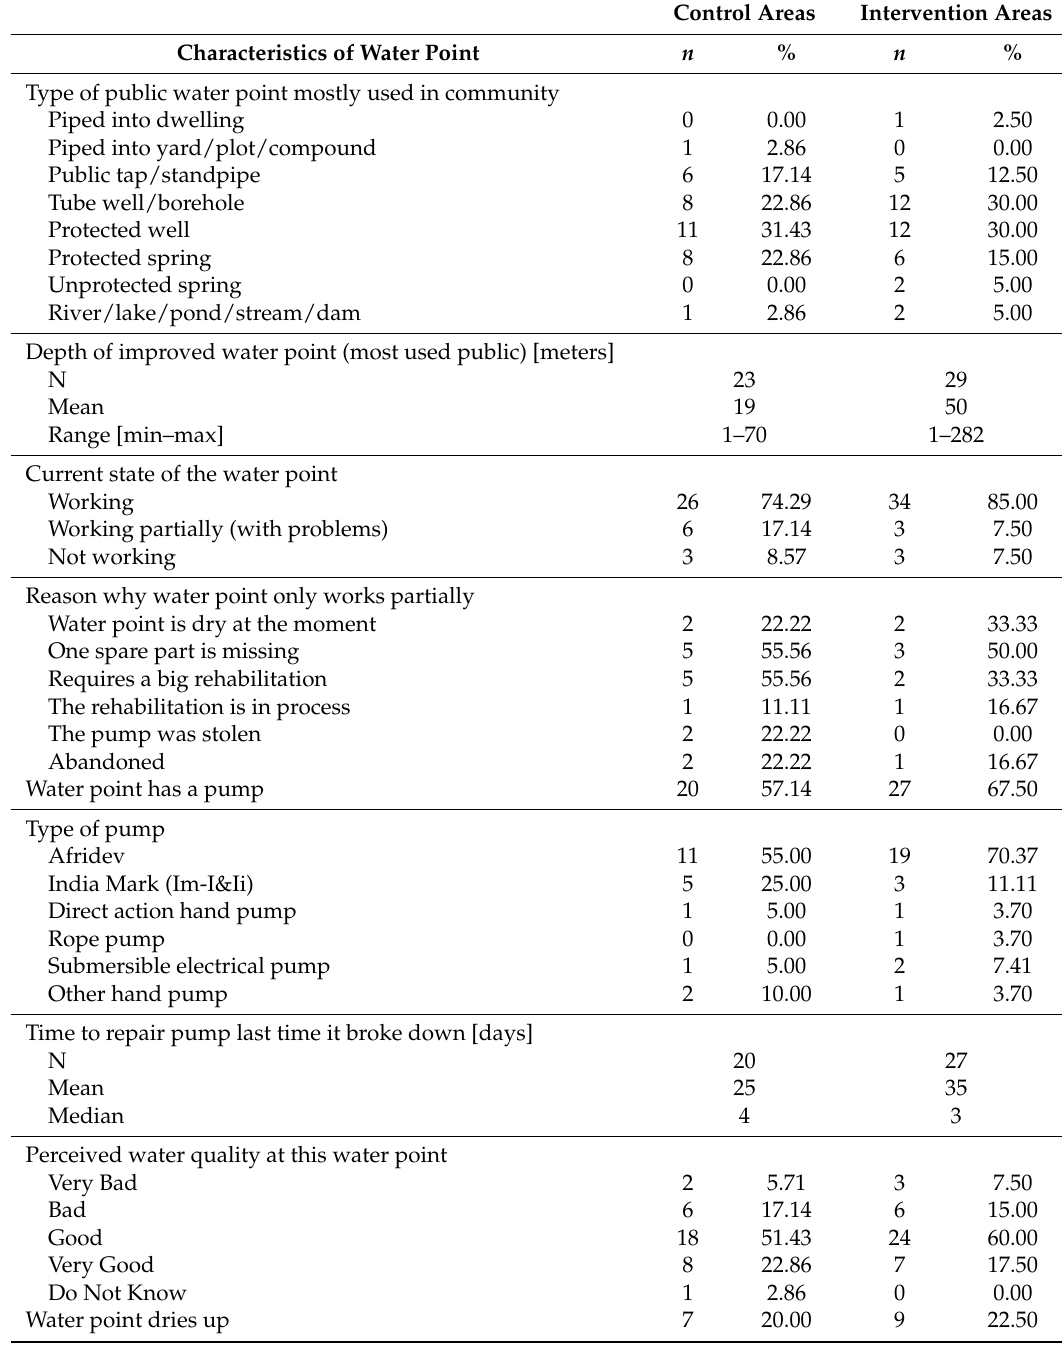
Table 5. Characterization of water points in intervention and control